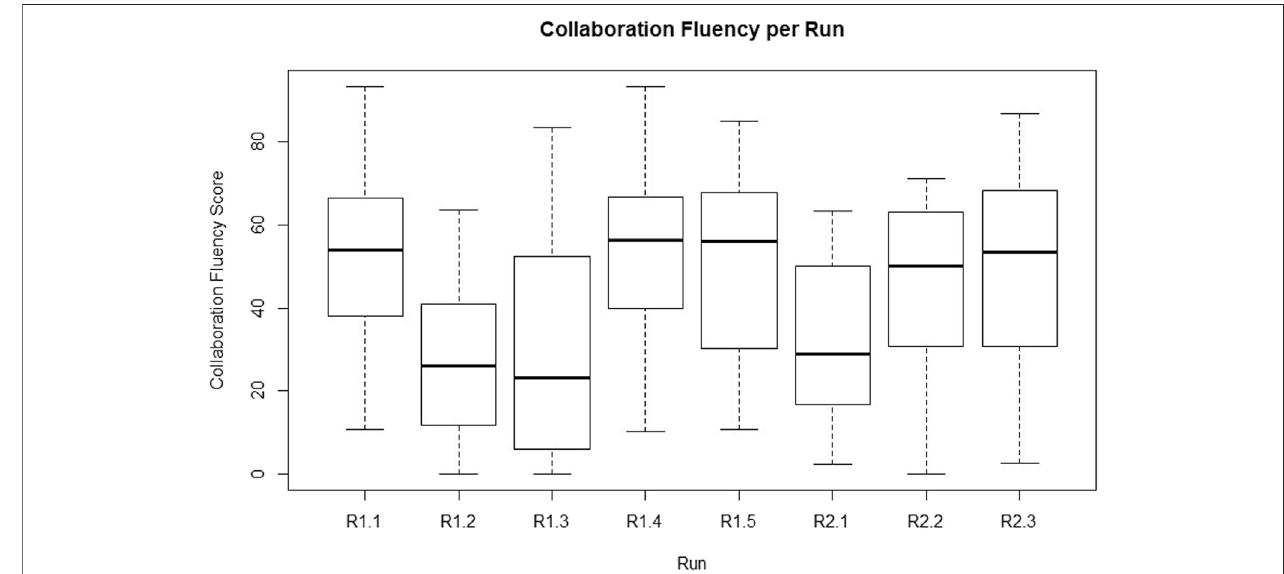
FIGURE 7 | The Collaboration Fluency scores per run in the experiment for all participants.